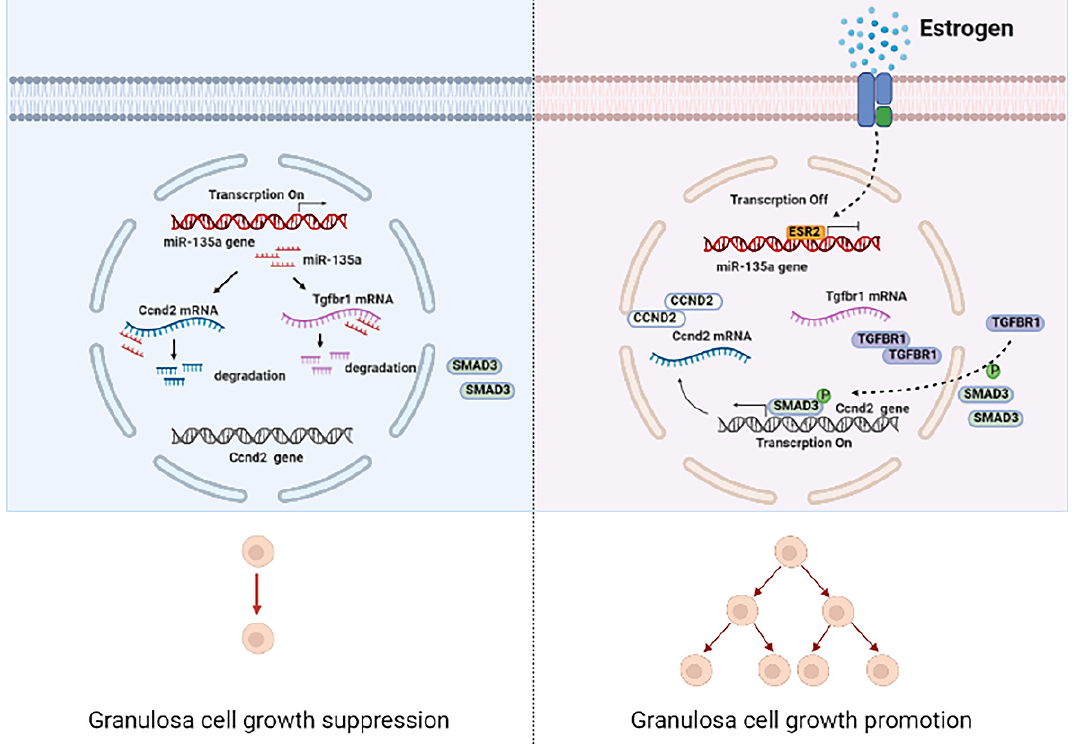
Figure 6. A schematic model for miR-135a regulating granulosa cell growth . The schematic diagram depicting the mechanism that miR-135a regulates murine granulosa cell growth. First, miR-135a binds to 3 ′ UTR of Tgfbr1 and Ccnd2 to repress their expression. Then, downregulated TGFBR1 fails to facilitate nuclear distribution of SMAD3, which could not enhance Ccnd2 expression. Finally, ESR2 functions as a transcription factor to directly bind to the miR-135a promoter region, decreases the transcriptional activity of miR-135a, and eventually suppresses miR-135a-mediated mGC growth suppression. It has been suggested that miR-135a is closely related to the negative regulation of TGF β -SMAD signaling pathway. miR-135a suppresses TGF- β -mediated